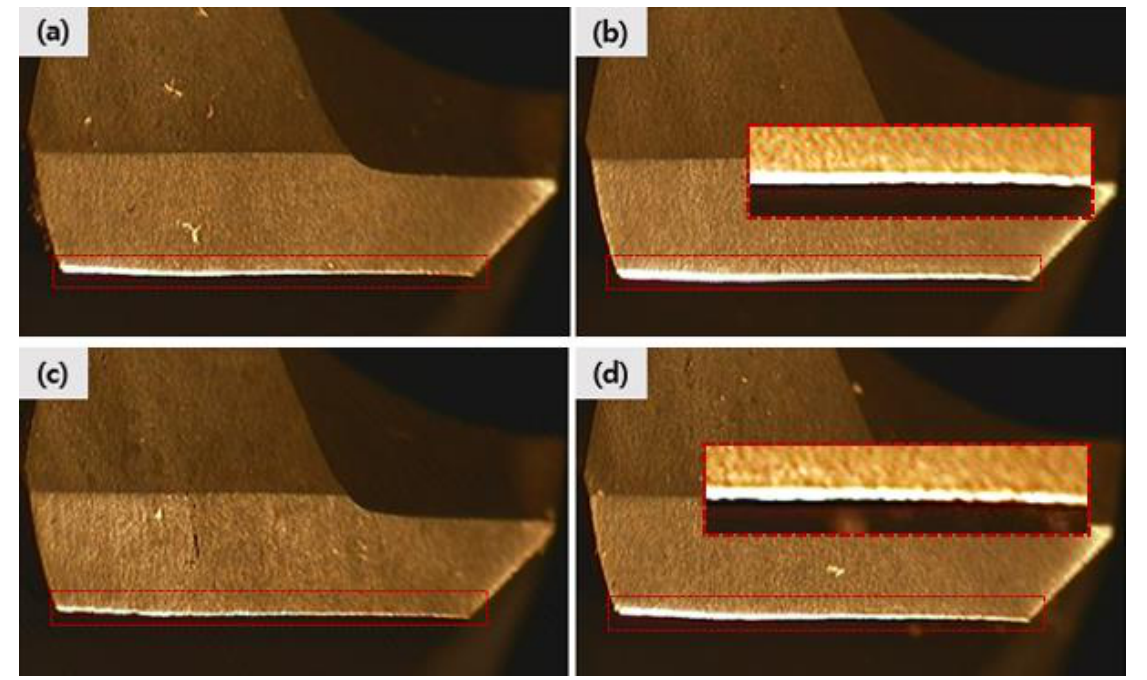
Figure 9. SEM images of carbide drill after drilling 30 and 300 holes for CFRP ( a , b ) and C-AFRP ( c , d ).